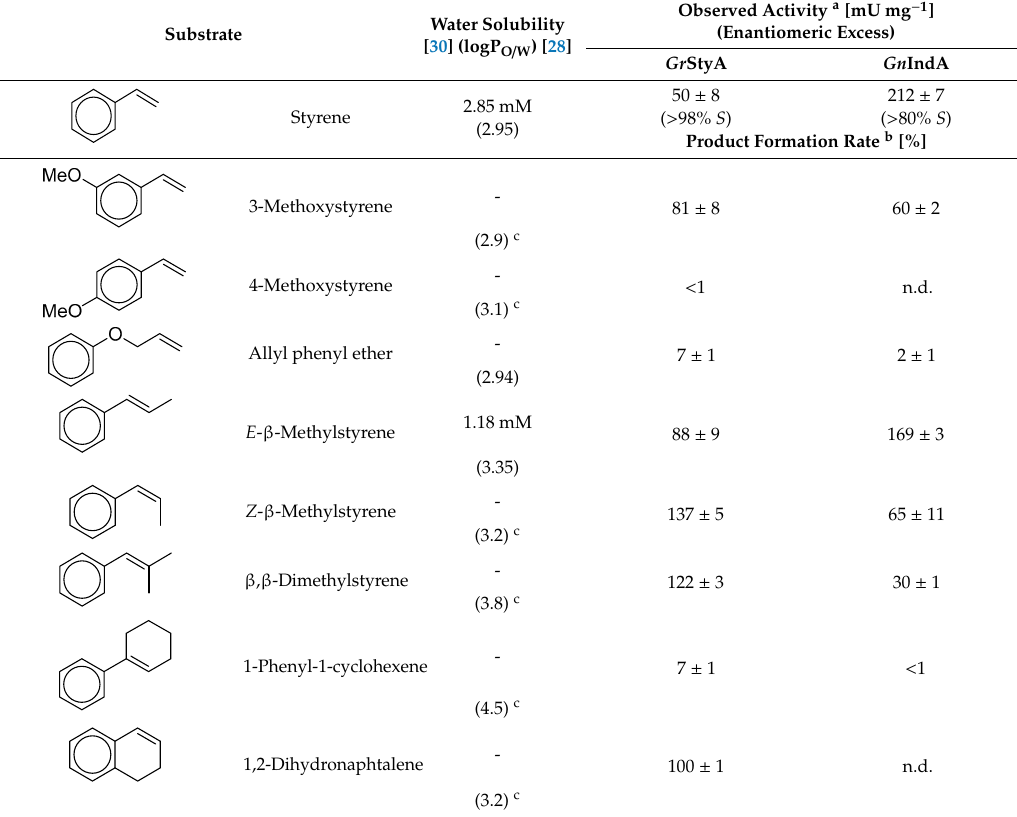
Table 1. Conversion of di ff erent substrates by flavin-dependent monooxygenases. Table 1. Conversion of different substrates by flavin-dependent monooxygenases. Table 1. Conversion of different substrates by flavin-dependent monooxygenases. Table 1. Conversion of different substrates by flavin-dependent monooxygenases. Table 1. Conversion of different substrates by flavin-dependent monooxygenases. Table 1. Conversion of different substrates by flavin-dependent monooxygenases. Table 1. Conversion of different substrates by flavin-dependent monooxygenases. Table 1. Conversion of different substrates by flavin-dependent monooxygenases. Table 1. Conversion of different substrates by flavin-dependent monooxygenases. Table 1. Conversion of different substrates by flavin-dependent monooxygenases. Substrate Substrate